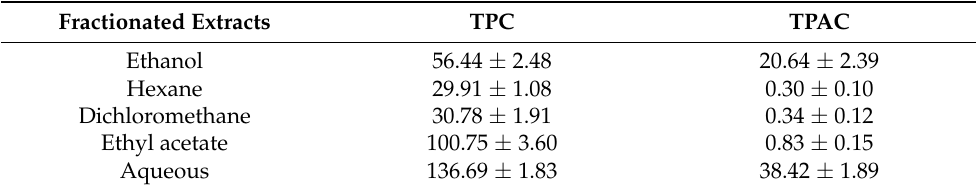
Table 2. Total phenolic content and total proanthocyanidins content of fractionated extracts from red rice extract.